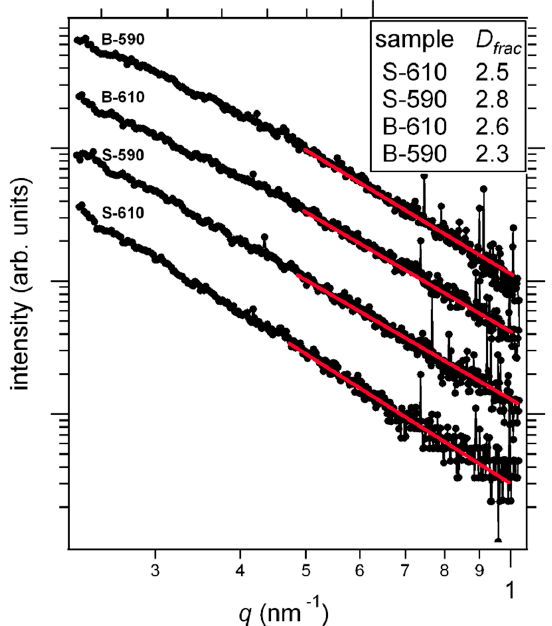
Figure 7. Porod plot for 1D intensity cut in the direction of the green line in Figure 5. The intensities have been offset vertically for clarity. Red lines represent the best fit to Equation (3).